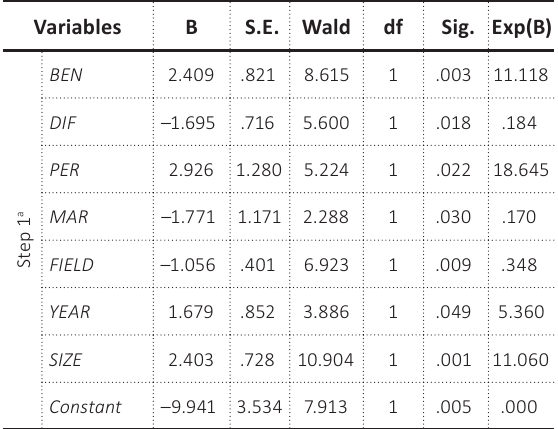
Table 9. Variables in the equation